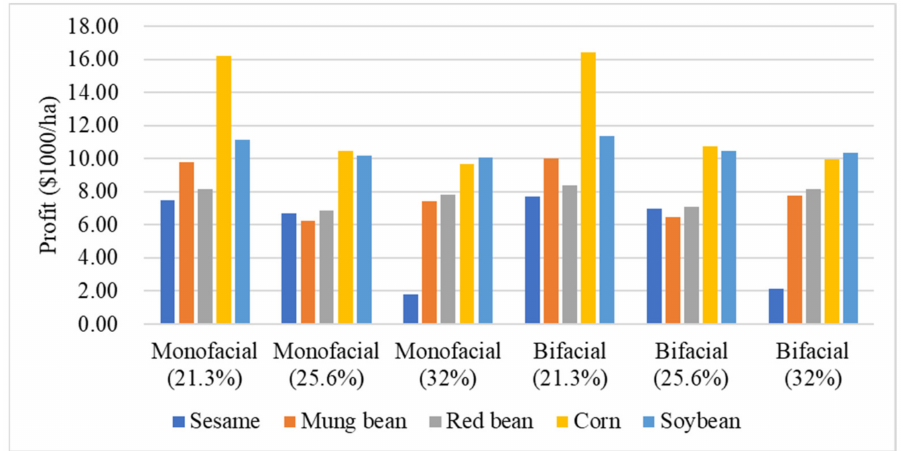
Figure 5. Estimated profits of the five crops grown under the six APV types (SMP-only case).